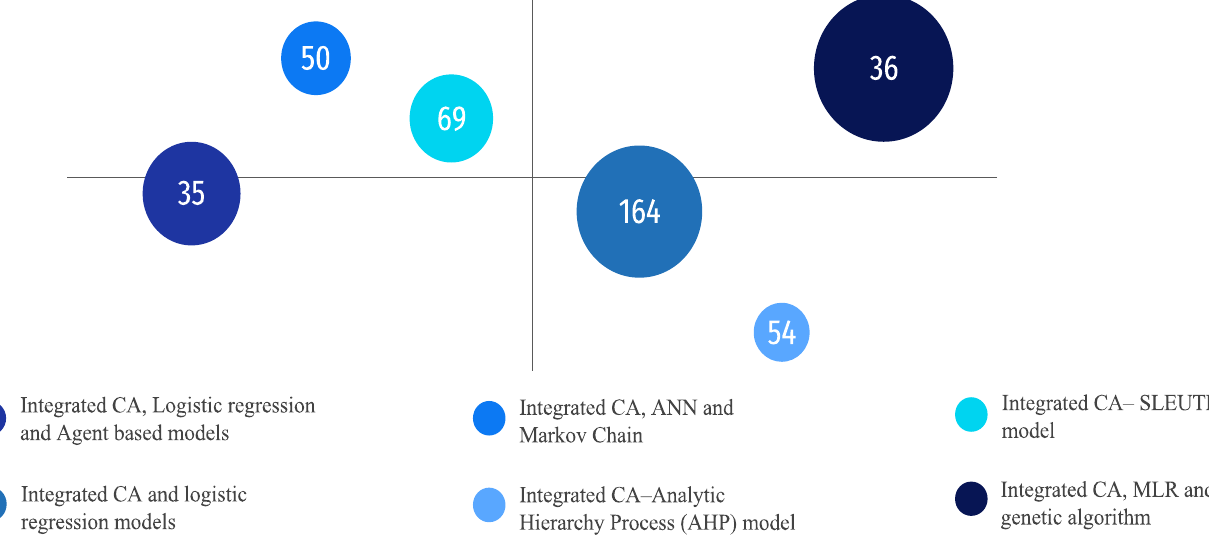
Figure 3. Number of research articles related to integrated CA models .